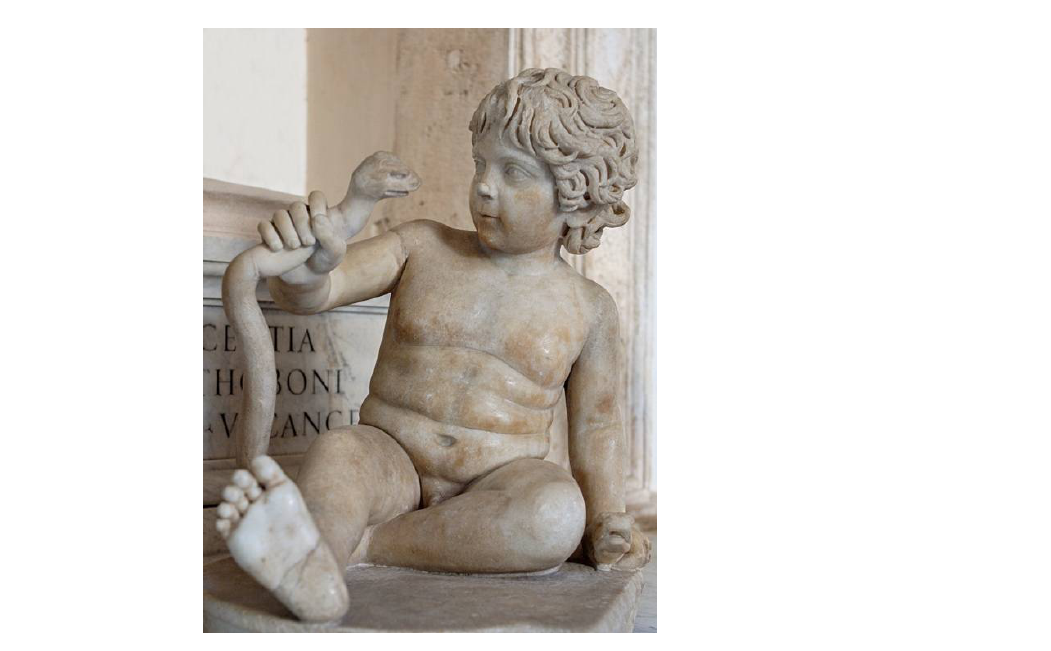
Figure 4. Herakles as a Boy Strangling a Snake , 2nd Century CE, Marble, Rome: Musei Capitolini. Photo: Wikipedia Commons, Public Domain.